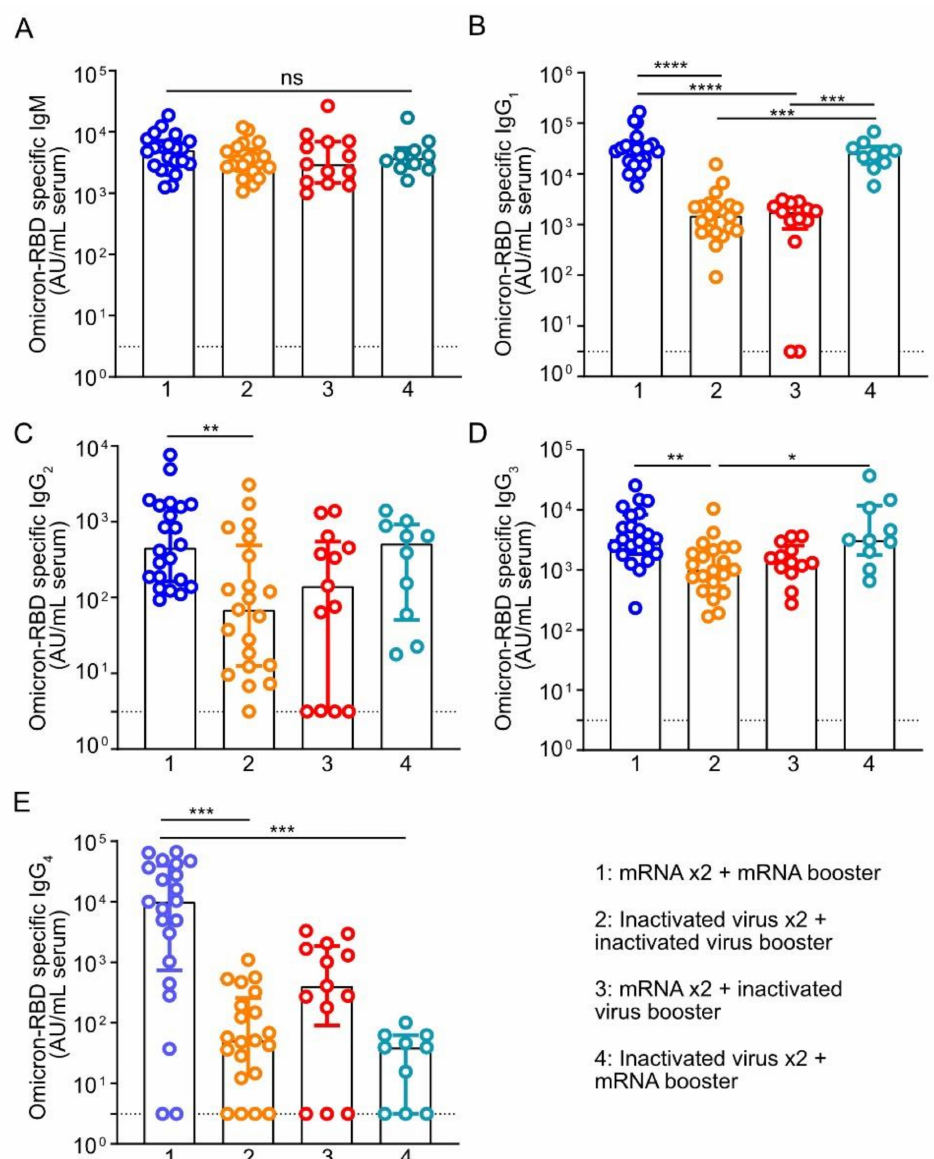
Figure 1. Antibody levels in individuals receiving third dose mRNA or inactivated virus vaccine booster. Comparison of ( A ) IgM or ( B ) IgG1 ( C ) IgG2 ( D ) IgG3 and ( E ) IgG4 against RBD of Omicron variant of SARS-CoV-2 spike protein in plasma samples obtained 28 ± 5 days post-immunization from individuals receiving (1) three doses of mRNA vaccines; (2) three doses of inactivated virus vaccines; (3) two doses of mRNA vaccines followed by a booster shot with inactivated virus; and (4) two doses of inactivated virus vaccines followed by a booster shot with mRNA vaccine. Each symbol represents a unique individual. Bars represent median antibody levels, and error bars show interquartile range (IQR). AU = arbitrary units. Statistical tests: Kruskal–Wallis test whereby * p < 0.05, ** p < 0.01, *** p < 0.001, **** p < 0.0001 and ns = not significant. The dotted line indicates a lower limit of detection of the assay (AU